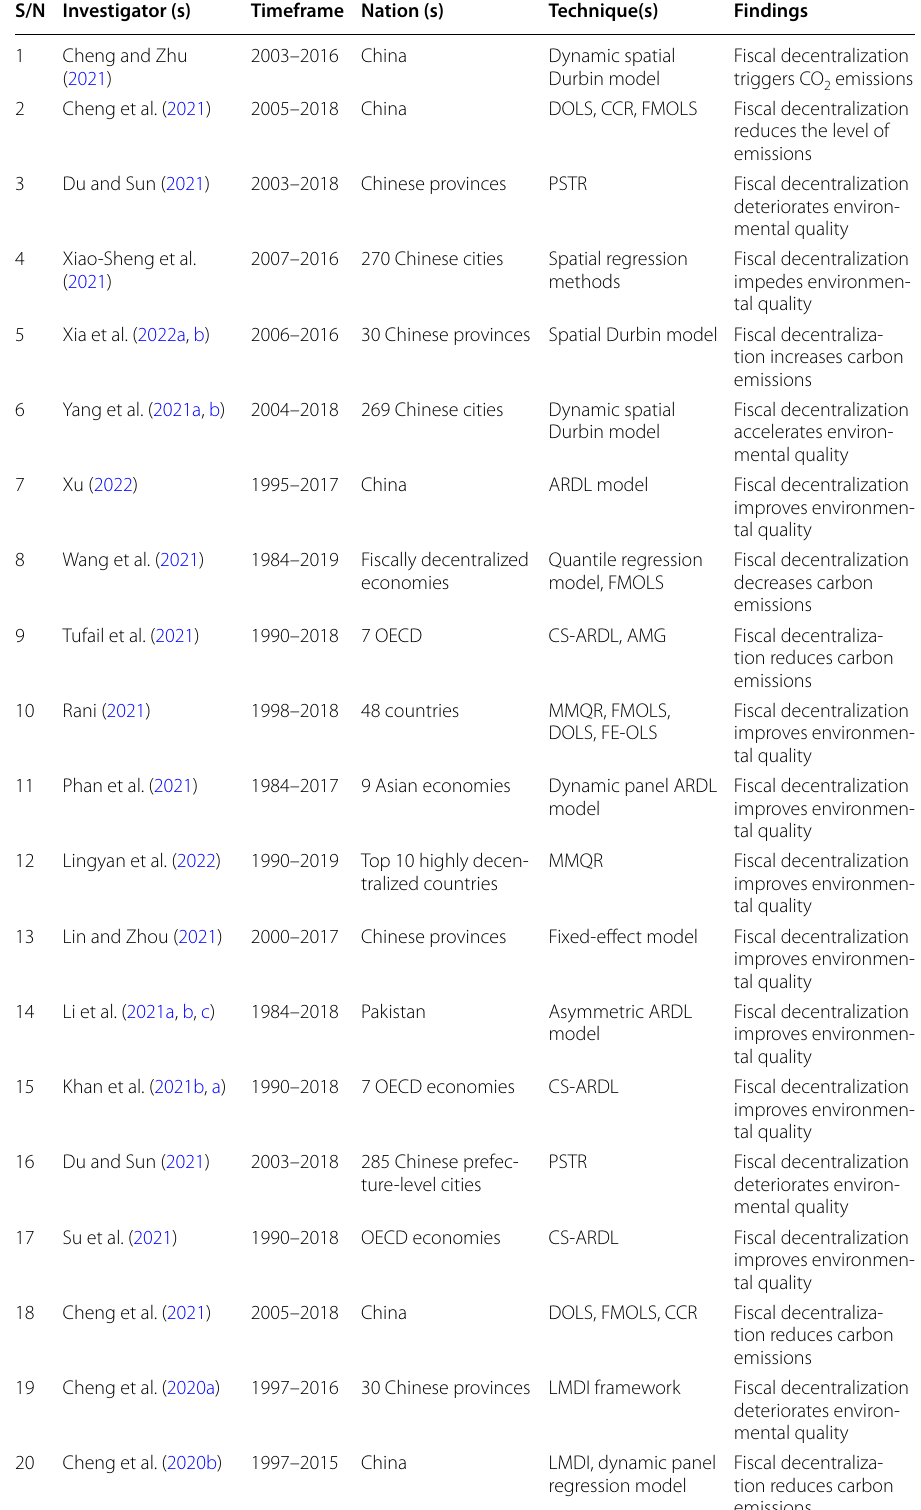
Table 1 Synopsis of studies S/N Investigator